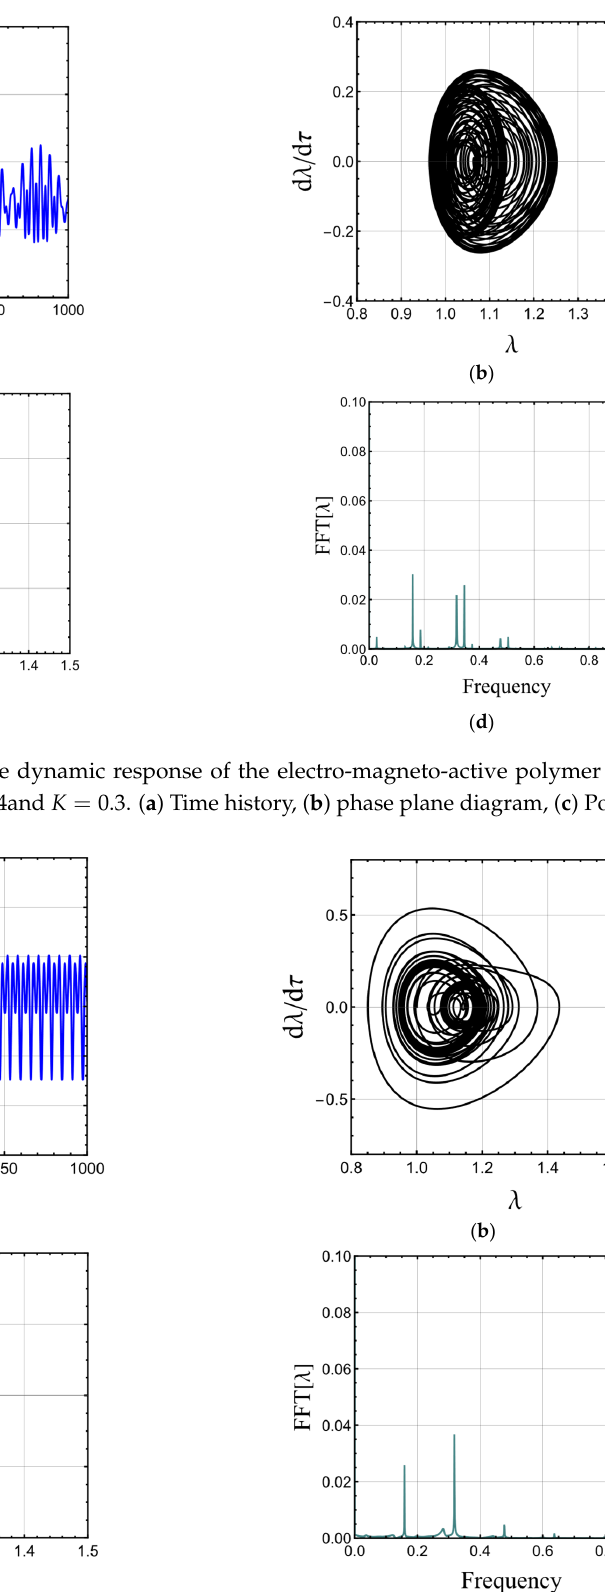
( d ) Figure 6. The dynamic response of the electro ‐ magneto ‐ active polymer to time ‐ varying voltage 𝐻(cid:3365) (cid:3404) 𝐻(cid:3365) (cid:2903) (cid:3404) 0.4 . ( a ) Time history, ( b ) phase plane diagram, ( c ) Poincaré map, and ( d ) FFT. Figure 7 also shows the results for the active polymer under time ‐ varying voltage, assuming 𝐻(cid:3365)